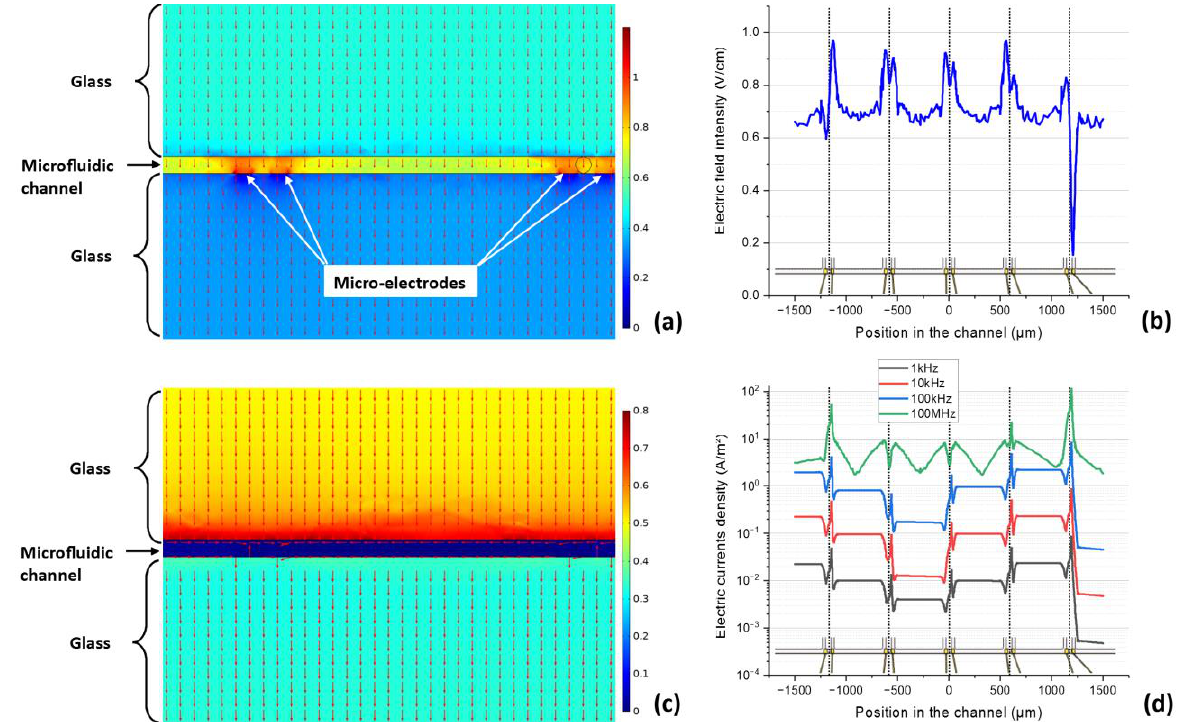
Figure 5. ( a ) Vertical cutaway of the simulated device in the middle of a microfluidic channel exposed to an electric field of 1 MHz and 1 V between the exposure electrodes. The colors correspond to the electric field intensity (V/cm) and the arrows to its direction. ( b ) Electric field intensity along the middle of the microfluidic channel. Vertical dotted lines correspond to the cell-trapping positions. The intensity peaks are caused by the five microelectrode pairs disturbing the field. ( c ) The same cutaway view as in ( a ), with exposure to an electric field of 1 MHz and 1 V between the exposure electrodes, but when the channel is full of an extracellular medium. ( d ) Electrical current density along the middle of the microfluidic channel at different frequencies. Vertical dotted lines correspond to the cell-trapping positions. Higher frequencies are more absorbed by the biological medium.